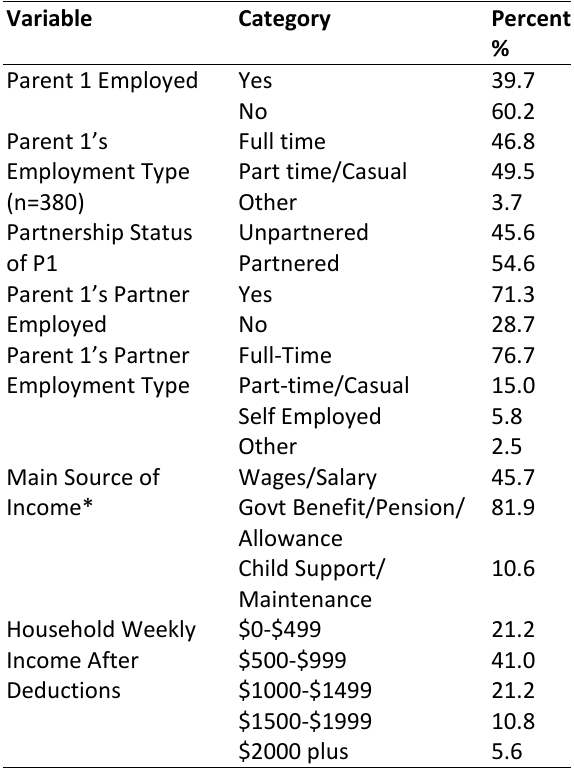
Table 2. Parent 1 socio-economic status details: LSIC Wave 6